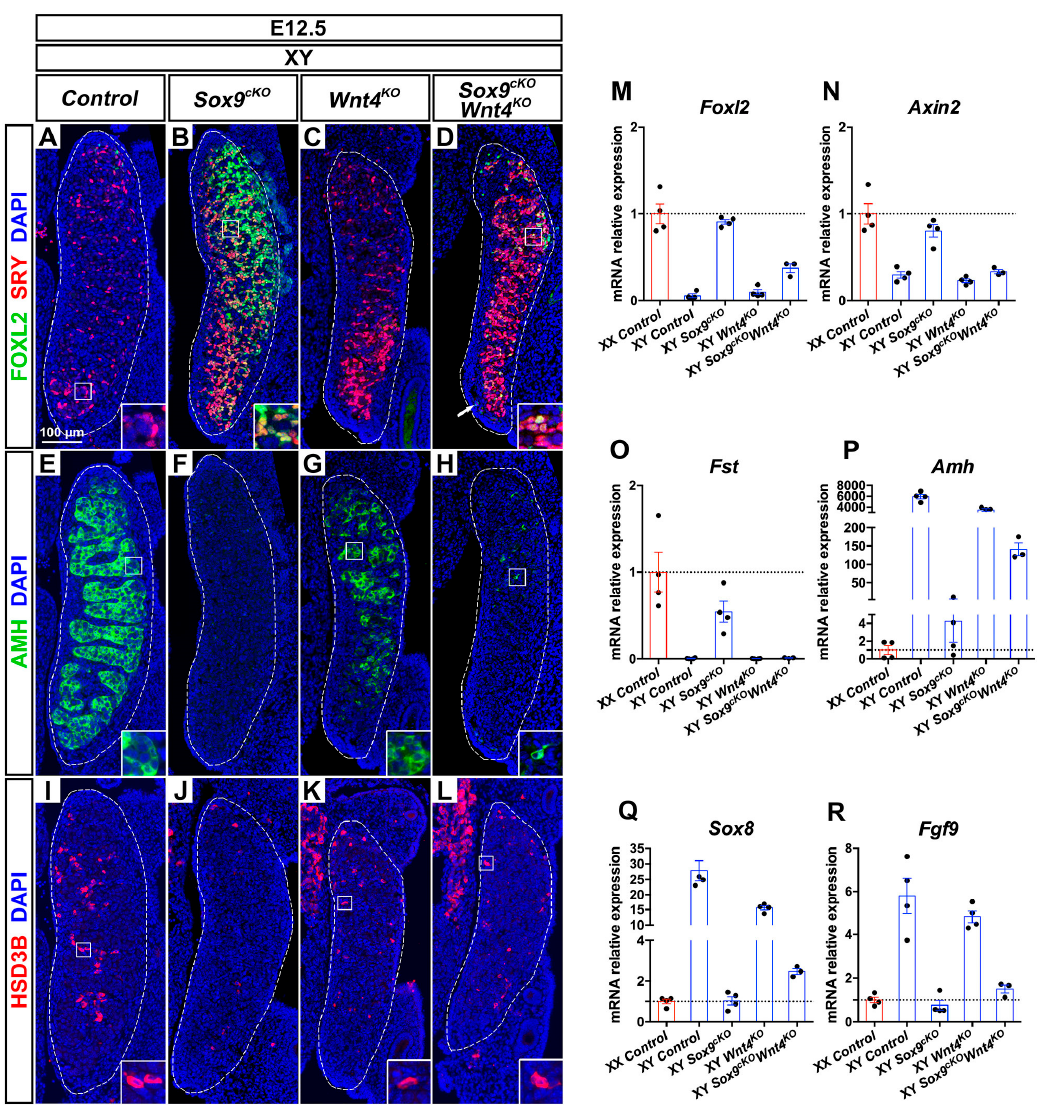
Figure 4. Phenotypic and gene expression changes in E12.5 XY Sox9; Wnt4 mutants ( A – D ). Immunodetection of the pre-granulosa cell marker FOXL2 (green) and the male supporting cell marker SRY (red) in E12.5 XY gonads of Control ( A ), Sox9 cKO ( B ), Wnt4 KO ( C ), and Sox9 cKO Wnt4 KO ( D ) genotypes. ( E – H ) Immunodetection of the Sertoli cell marker AMH (green) in E12.5 XY gonads of Control ( E ), Sox9 cKO ( F ), Wnt4 KO ( G ), and Sox9 cKO Wnt4 KO ( H ) genotypes. ( I – L ) Immunodetection of the steroidogenic enzyme HSD3B (red) in E12.5 XY gonads of Control ( I ), Sox9 cKO ( J ), Wnt4 KO ( K ), and Sox9 cKO Wnt4 KO ( L ) genotypes. ( M – R ) RT-quantitative PCR analysis of Foxl2 ( M ), Axin2 ( N ), Follistatin ( Fst ) ( O ), Amh ( P ), Sox8 ( Q ), and Fgf9 ( R ) expression in E12.5 gonads of XX Control , XY Control , XY Sox9 cKO , XY Wnt4 KO , and XY Sox9 cKO Wnt4 KO genotypes ( N = 3–4 embryos for each genotype). Expression level in XX controls is 1. Graphs show individual values (dots), and the mean fold-change (bars) ± SEM. Nuclei labeled with DAPI are shown in blue. Magnification is the same in all panels. Scale bar = 100 µ m. Gonads are outlined with broken white lines. The white arrow in D indicates the coelomic